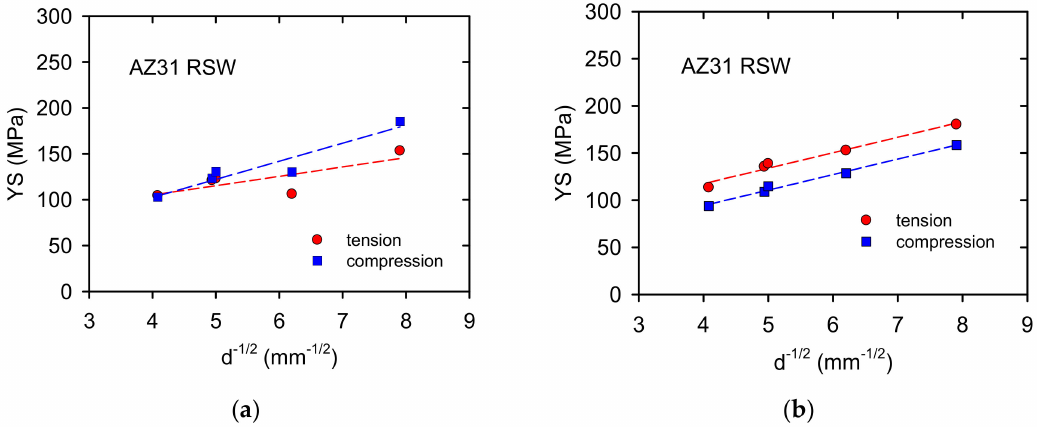
Figure 10. TYS and CYS depending on the grain size in the Hall-Petch plot: ( a ) measured values, ( b ) corrected